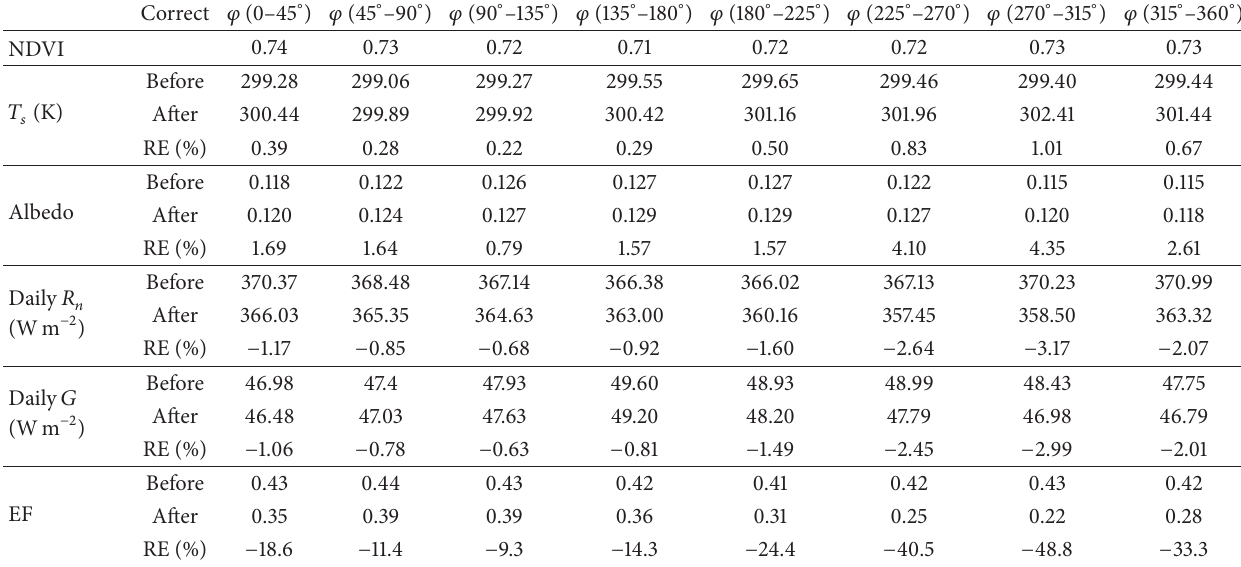
Table 2: The mean value and relative error (RE) of the surface parameters and energy fluxes before and after the topographic correction for the different terrain aspect angles over the selected